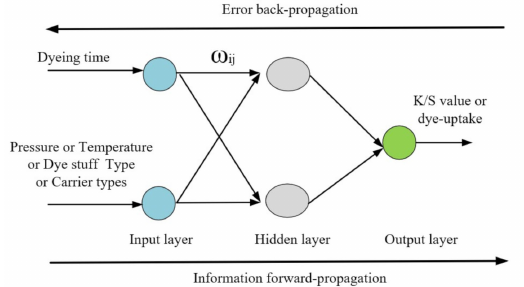
Figure 3. Schematic architecture of the designed Back Propagation Neural Network (BPNN) model.